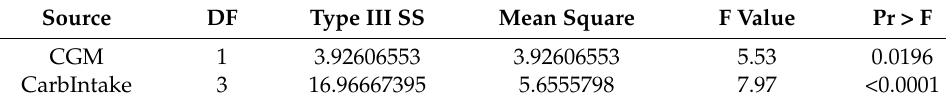
Table A1. A1C with CGM and CarbIntake as independent variables.